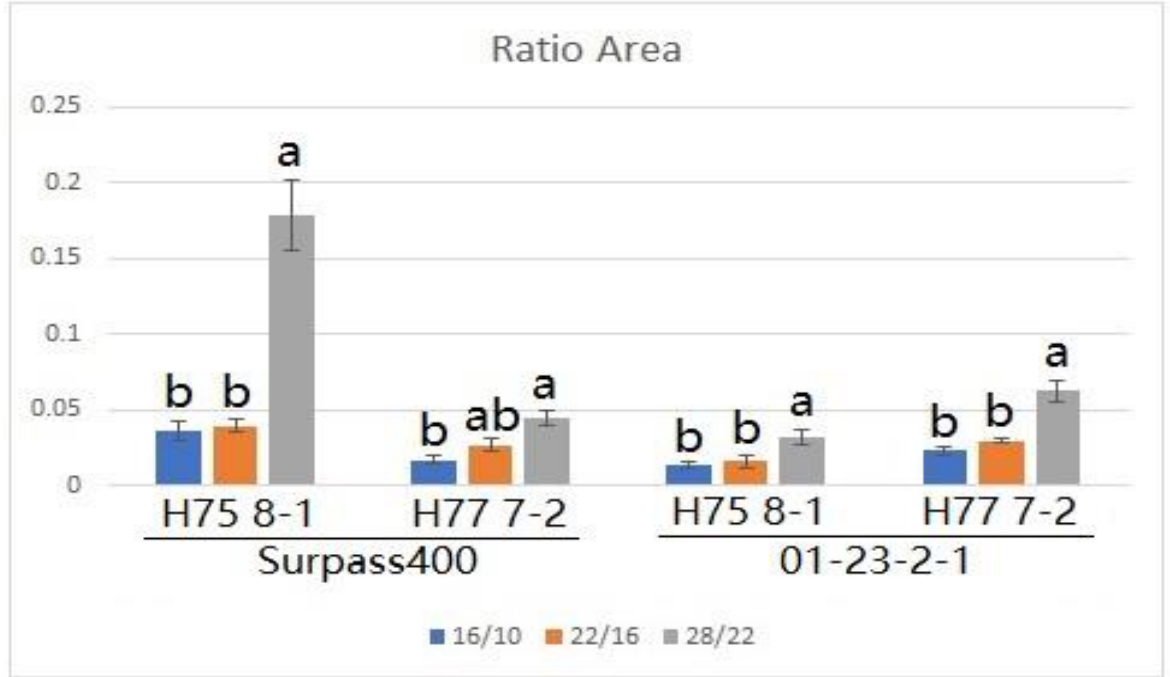
Figure 2. The extent of blackleg lesion development at 11 dpi from Surpass400 and 01-23-2-1 inoculated by the isolates HCRT75 8-1 and HCRT77 7-2. The inoculated plants were exposed to three temperature treatments: 16 °C/10 °C, 22 °C/16 °C and 28 °C/22 °C (day/night: 16 h/8 h). The lesion development was calculated by the ratio between the area of the lesion and the area of the cotyledon. Error bars represent standard error of the mean. Different lowercase letters suggest the significant differences among mean values (Fisher’s Least Significant Difference; p < 0.05). The results are based on three replicates in three independent experiments.